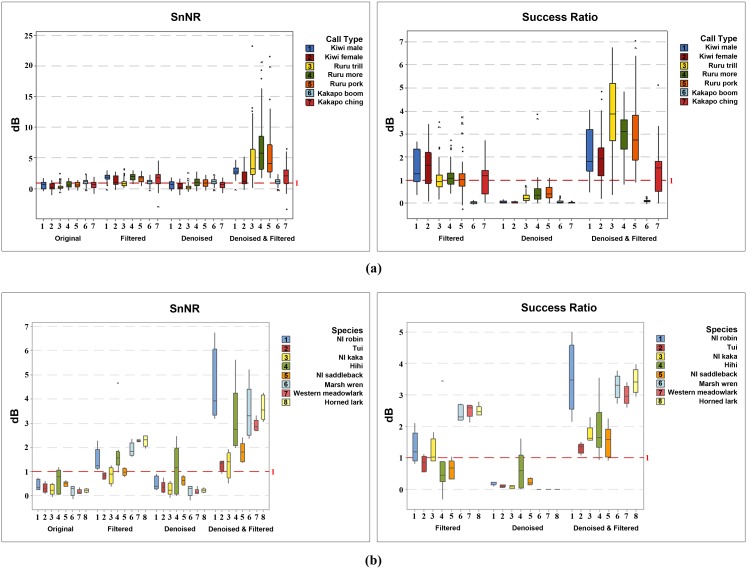
Box plot view of the results in (a) Table 3 and (b) Table 4.